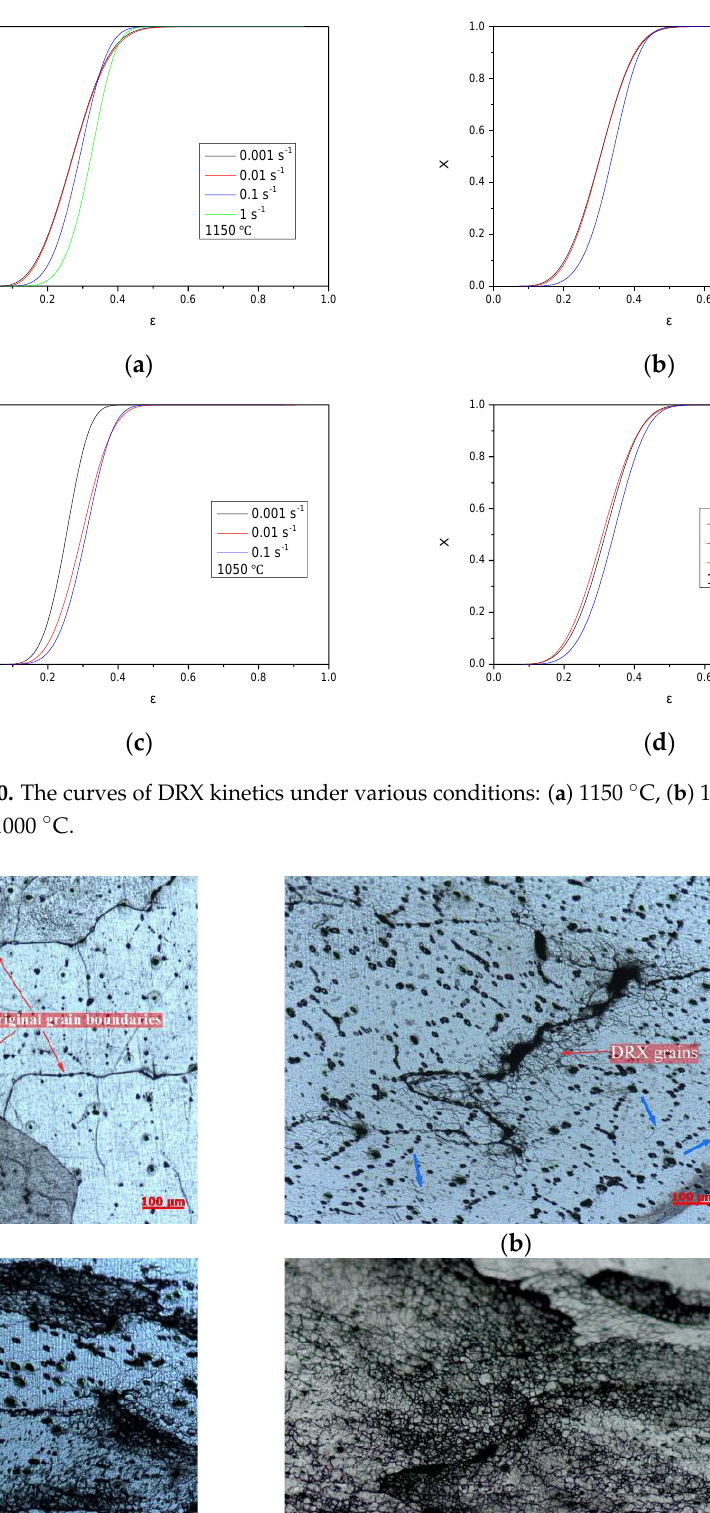
(22) Figure 9. The relationship between ln[−ln(1 − 𝑋 DRX )] and ln[ (𝜀−𝜀 𝑐 ) 𝜀 ∗ ] at 1150 °C and 1 s −1 . The same method was used to determine the kinetic model under other conditions. Figure 10 shows the DRX kinetic curves under different conditions. As shown in Figure 10, DRX only occurs when strain exceeds the critical strain. It also shows that 𝑋 DRX in-